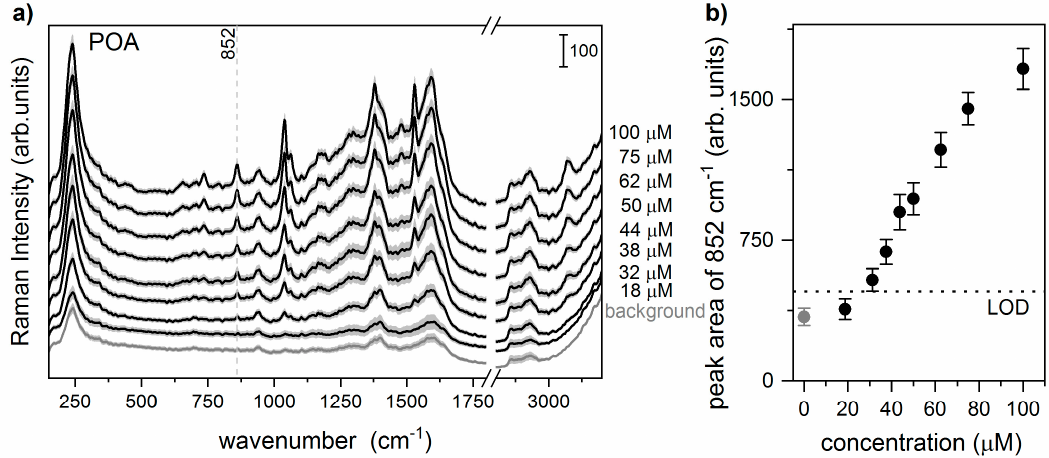
Figure 4. ( a ) LoC-SERS mean spectra of di ff erent concentrated POA in water as indicated in the plot. The standard deviation values are indicated in grey; ( b ) the integrated intensity of the marked peak centered at 852 cm − 1 .